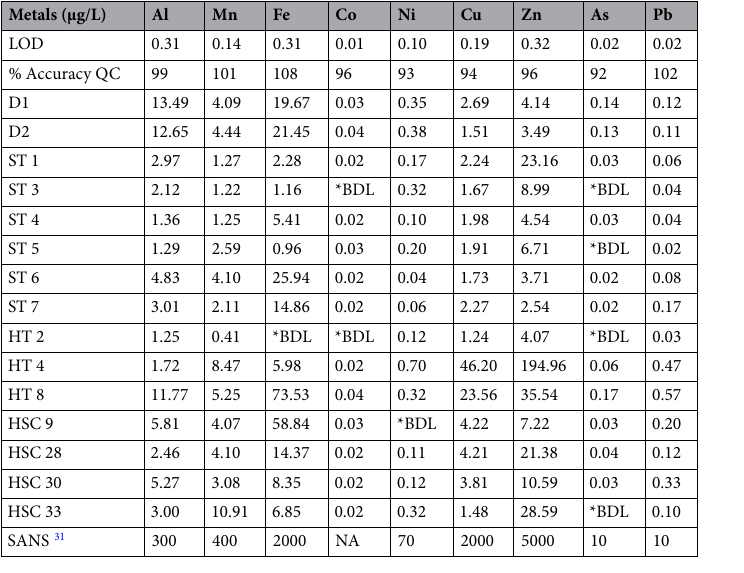
Table 8. Concentration of trace metals in water. LOD—Limit of detection; *BDL -below detection limit; NA— Not